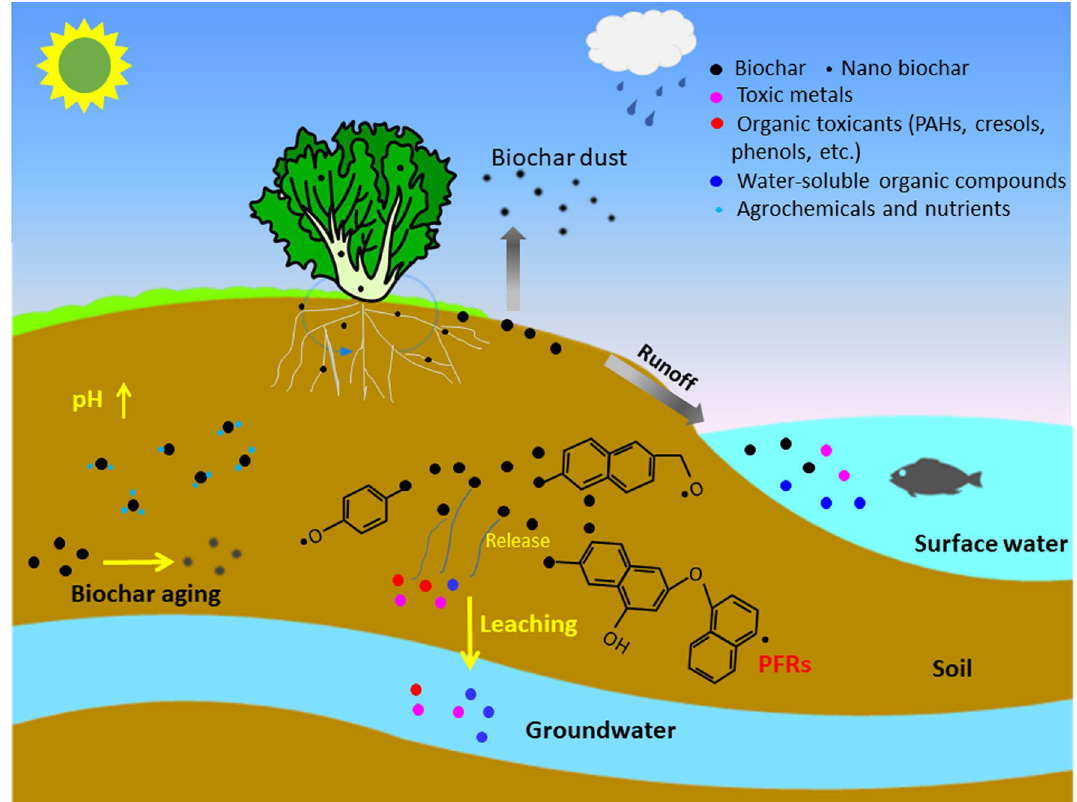
Fig. 7 Potential risks associated with biochar application to